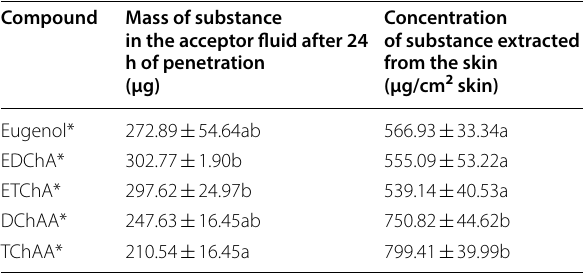
Table 5 Results of studies on the penetration of active substances through pig skin and the amounts of extracted active ingredients accumulated in